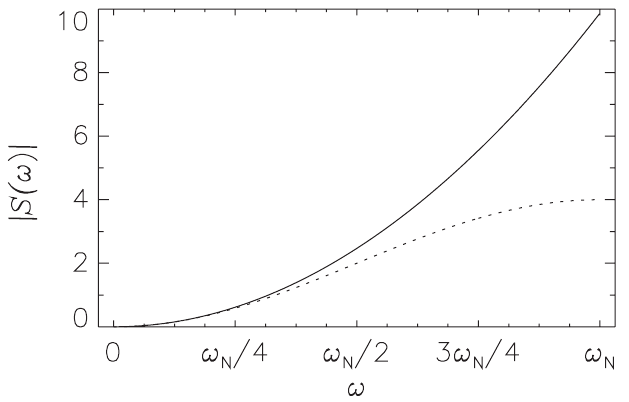
FIG. 2. Transfer function S (cid:2) ! (cid:3) for the continuous operator (cid:2) (solid line) and for the discretized operator L with a 3-point is the Nyquist frequency, the highest stencil (dotted line). ! N frequency representable at a given grid